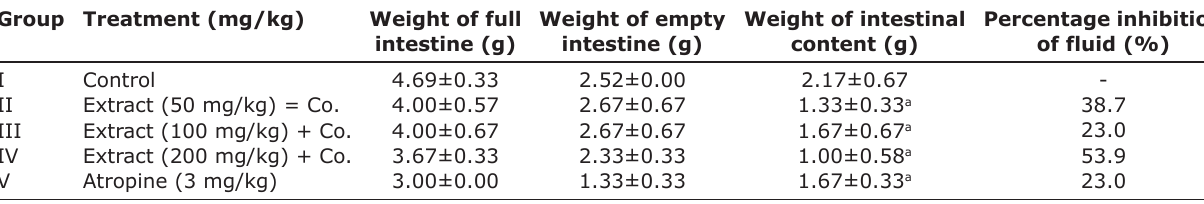
Table-3: Effect of aqueous root bark extract of Byrsocarpus coccineus on castor oil-induced enteropooling. Group Treatment